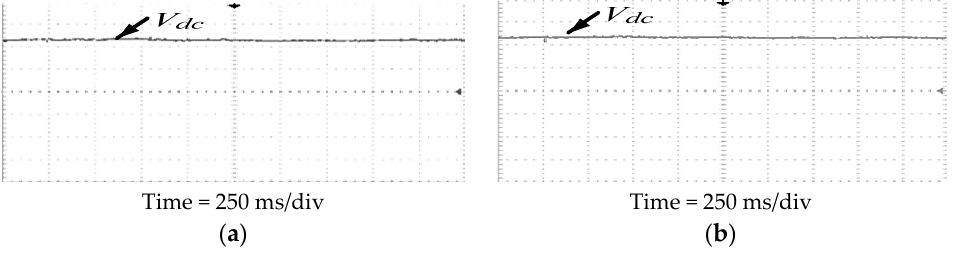
Figure 19. DC bus voltage (cid:1848) (cid:3031)(cid:3030) (200 V/div) resulting from SAPF ( a ) with FLC ( b ) without